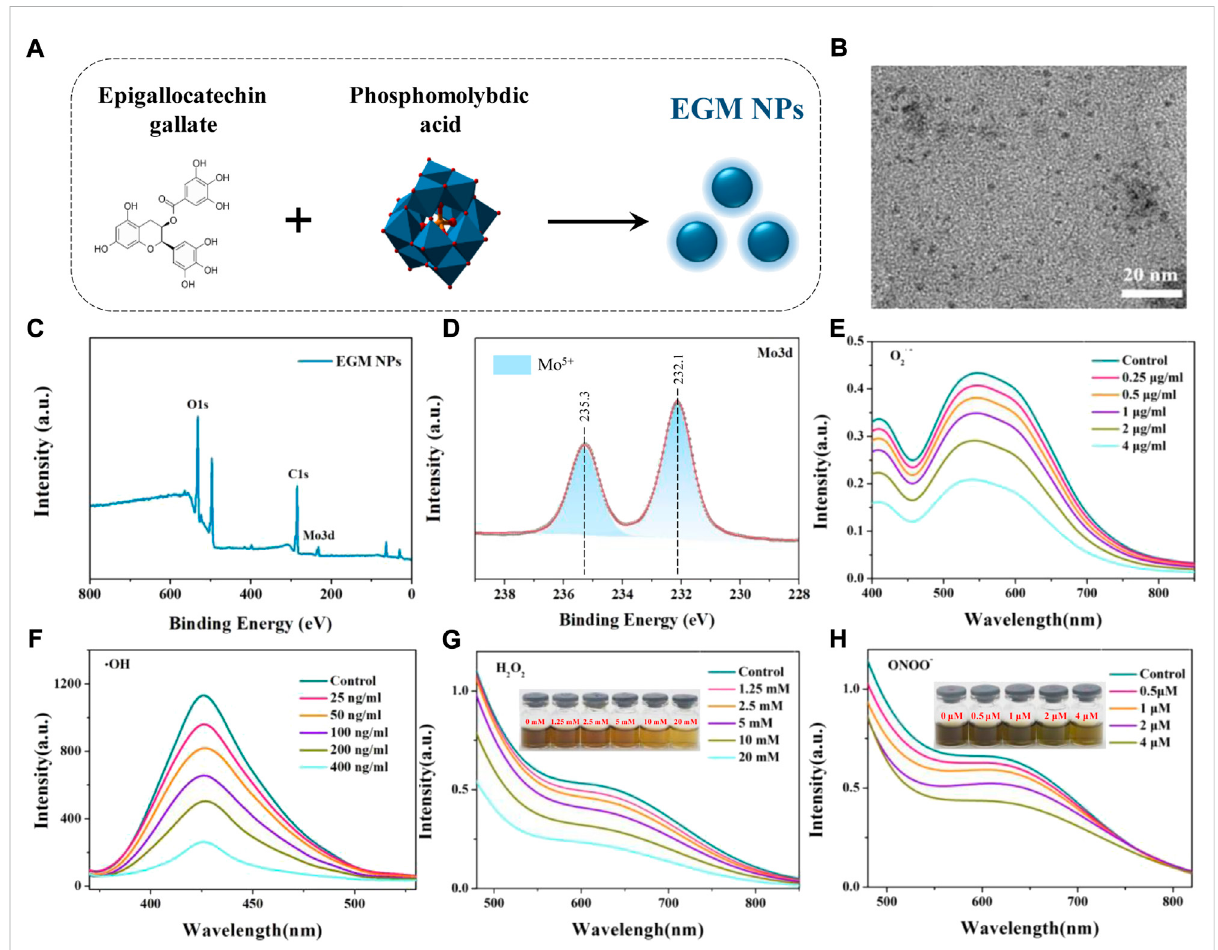
FIGURE 1 Synthesis and characterization of EGM NPs. (A) Schematic illustration of synthesis of EGM NPs. (B) TEM image of EGM NPs in water, scale bar: 20 nm. (C) X-ray photoelectronspectroscopy (XPS) spectrumof EMGNPs. (D) XPS spectrumofMo inEMG NPs. (E – H) O 2 .- (E) ,OH (F) ,H 2 O 2 (G) , and ONOO − (H) scavenging ability of EGM